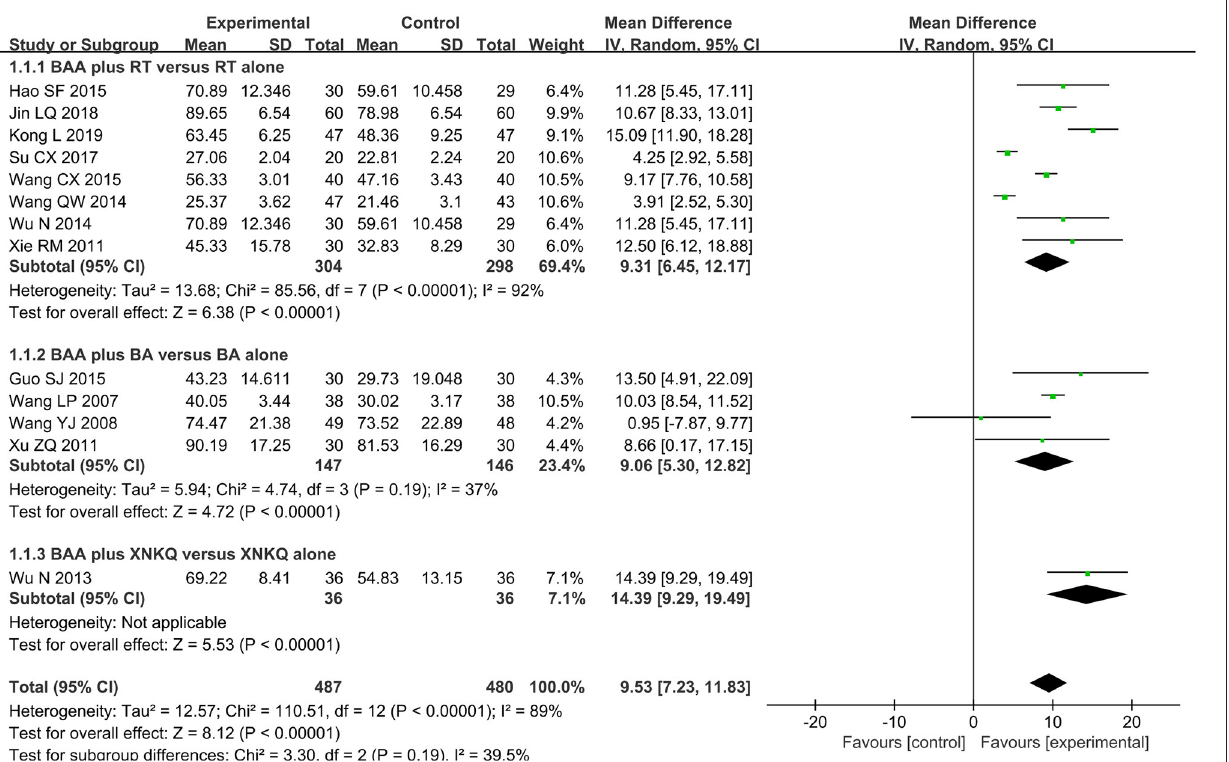
FIGURE 3 | Forest plot and meta-analysis of FMA. (BA, body acupuncture; BAA, Bo’s abdominal acupuncture; CI, confidence interval; FMA, Fugl-Meyer Assessment Scale; RT, rehabilitation training; XNKQ, Xingnao kaiqiao acupuncture).